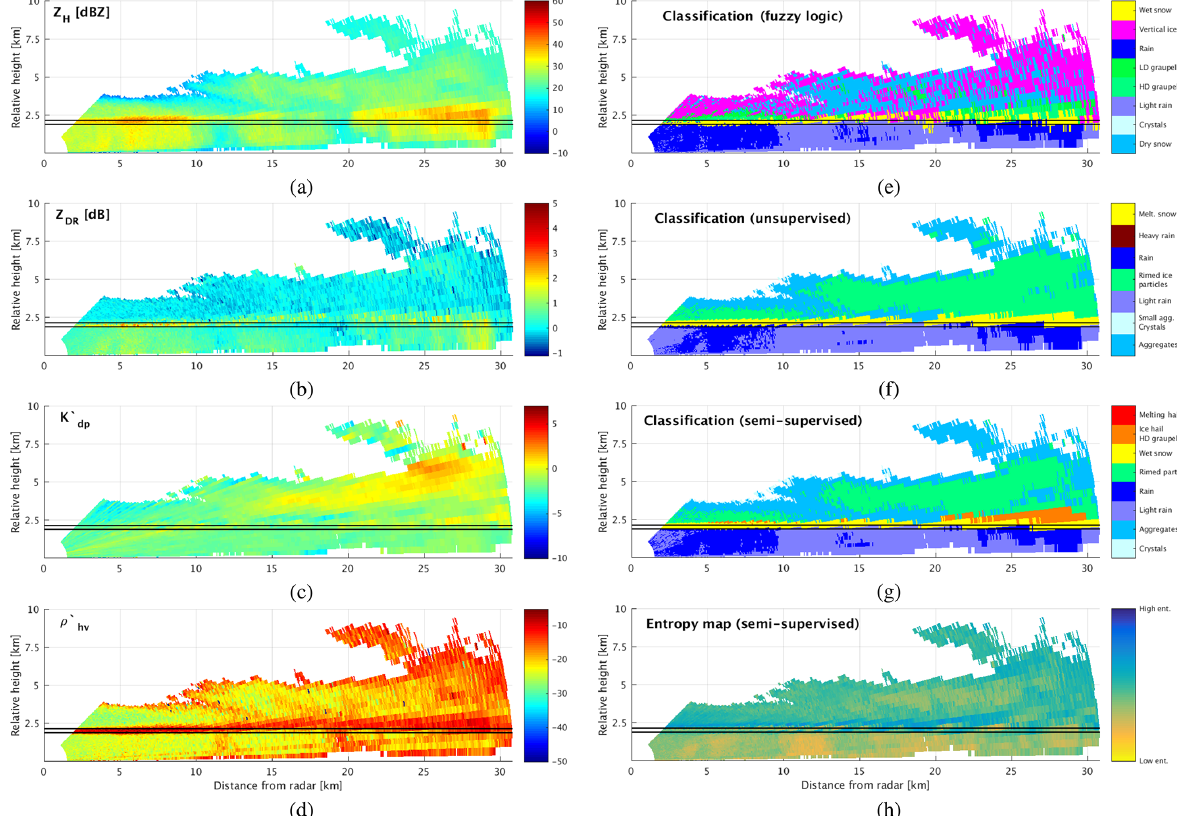
Figure 9. MXPol RHI profile 226 . 8 ◦ azimuth, 14:25UTC, 29 September 2013, in Ardèche, France: (a) Z H , (b) Z DR , (c) K (cid:48) Comparison of semi-supervised approach (g) with its supervised (e) and unsupervised counterpart (f) , along with the entropy estimate of the semi-supervised approach (h)